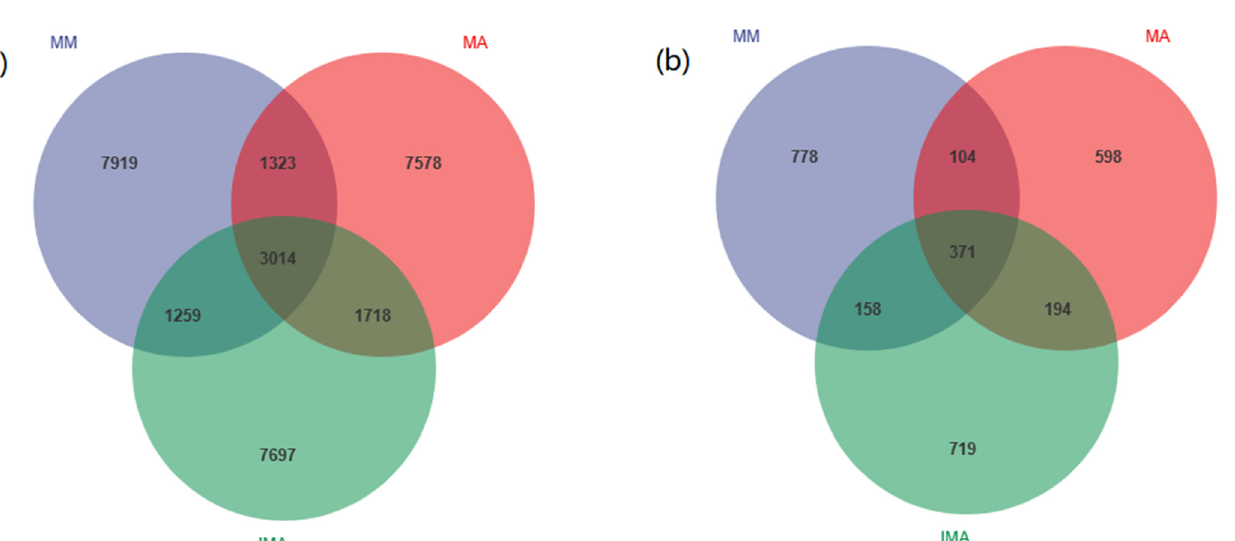
Figure 2. Relative abundance of species composition at the soil microbial phylum level in different treatments. ( a ): Relative abundance of bacterial phylum-level species composition; ( b ): Relative abundance of fungal phylum-level species composition. MM: Morus alba ; MA: Medicago sativa ; IMA: Morus alba – Medicago sativa . Table 2. Effects of intercropping on the relative abundance of phylum level dominant bacteria and fungi. Phylum MM MA IMA